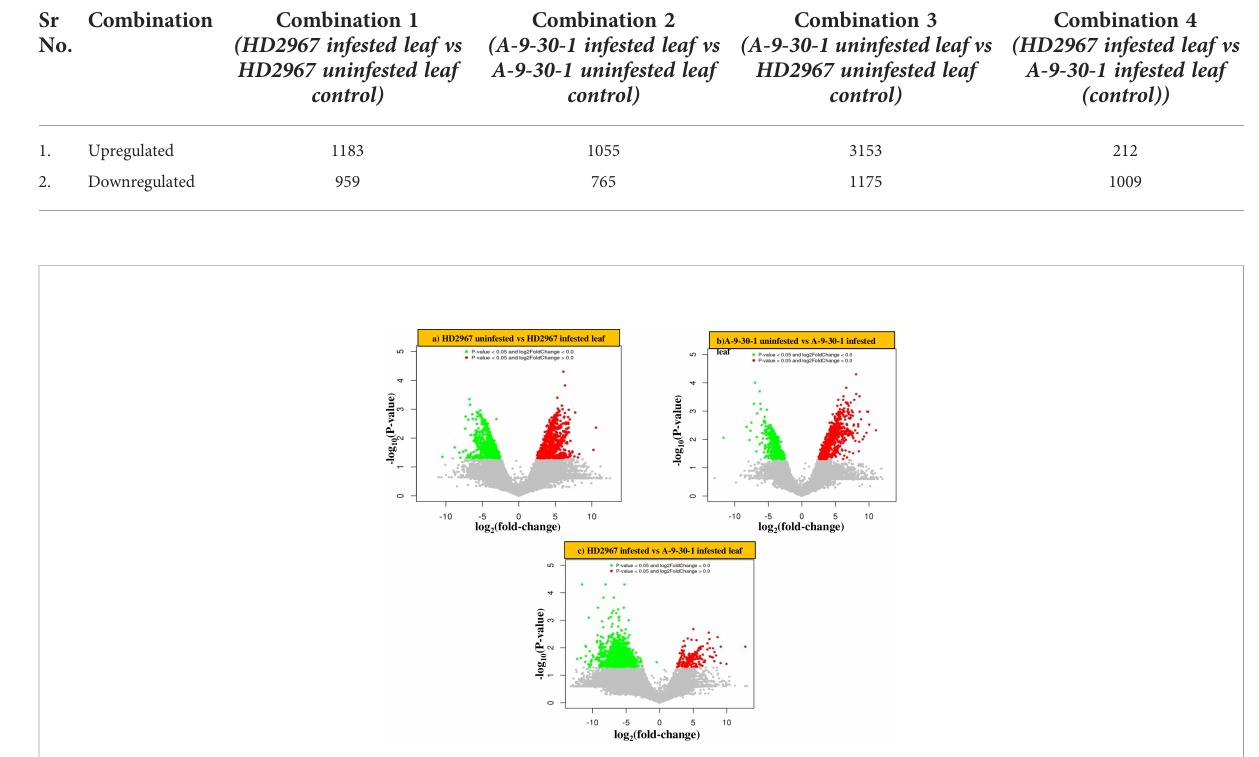
FIGURE 2 Differentially expressed genes (DEGs) revealing Volcano plots (A) HD2967 uninfested leaf vs HD2967 infested leaf after 48 h (B) A-9-30-1 uninfested leaf vs A-9-30-1 infested leaf after 48 h (C) HD2967 infested leaf vs A-9-30-1 infested leaf after 48 h of R. maidis feeding. The red block on the right side of zero represents the upregulated genes, whereas the green block on the left side of zero represents signi fi cant downregulated genes. The Y-axis represents the negative log of P-value ( p value <=0.05) of the performed statistical test, where data points with low p-values (highly signi fi cant) appearing towards the top of the plot. The grey block shows the non-differentially expressed